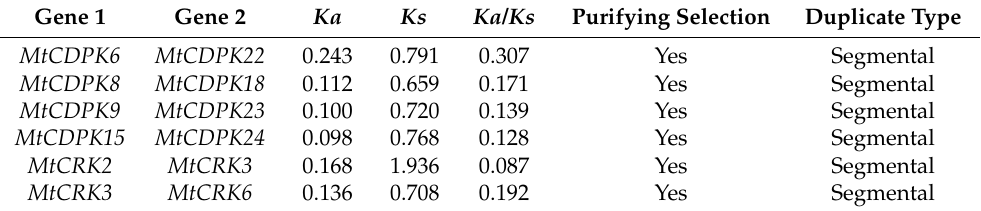
Figure 1. Phylogenetic relationships of CDPK and CRK proteins in M. truncatula (red circle), A. thaliana (blue square), and O. sativa (green triangle). The tree was constructed using MEGA7.0 software by the Neighbor-Joining method. The numbers next to the branch showed the 1000 bootstrap replicates expressed in percentage. The phylogenetic groups of MtCDPKs and MtCRKs were marked by different colors and legends. Table 2. Duplications of the CDPK and CRK genes in Medicago